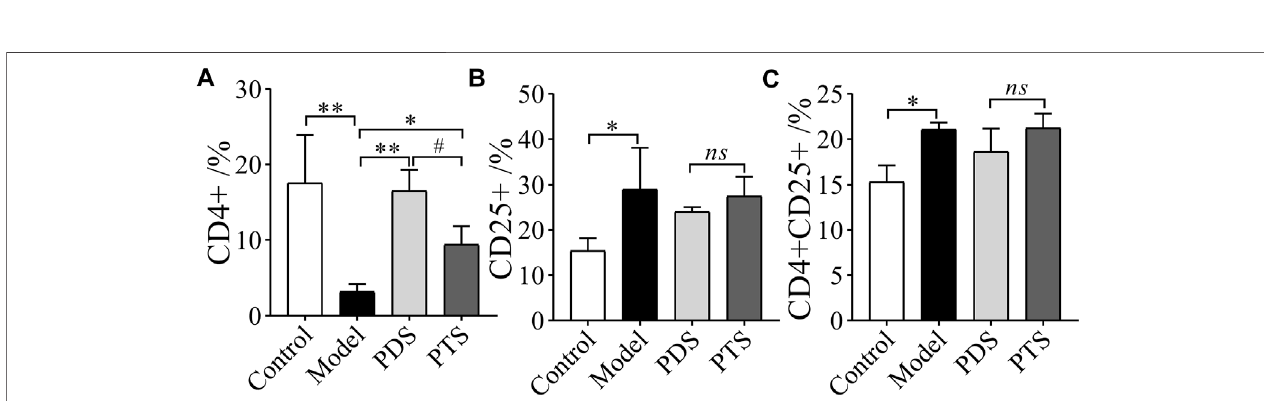
FIGURE 9 | The effect of PDS and PTS on spleen histopathology in myelosuppression mice. (A) control group; (B) model group; (C) PDS group; (D) PTS group. (WP- white pulp, RP- red pulp, Scor-splenic corpuscle, CA-central artery, MZ-marginal zone).